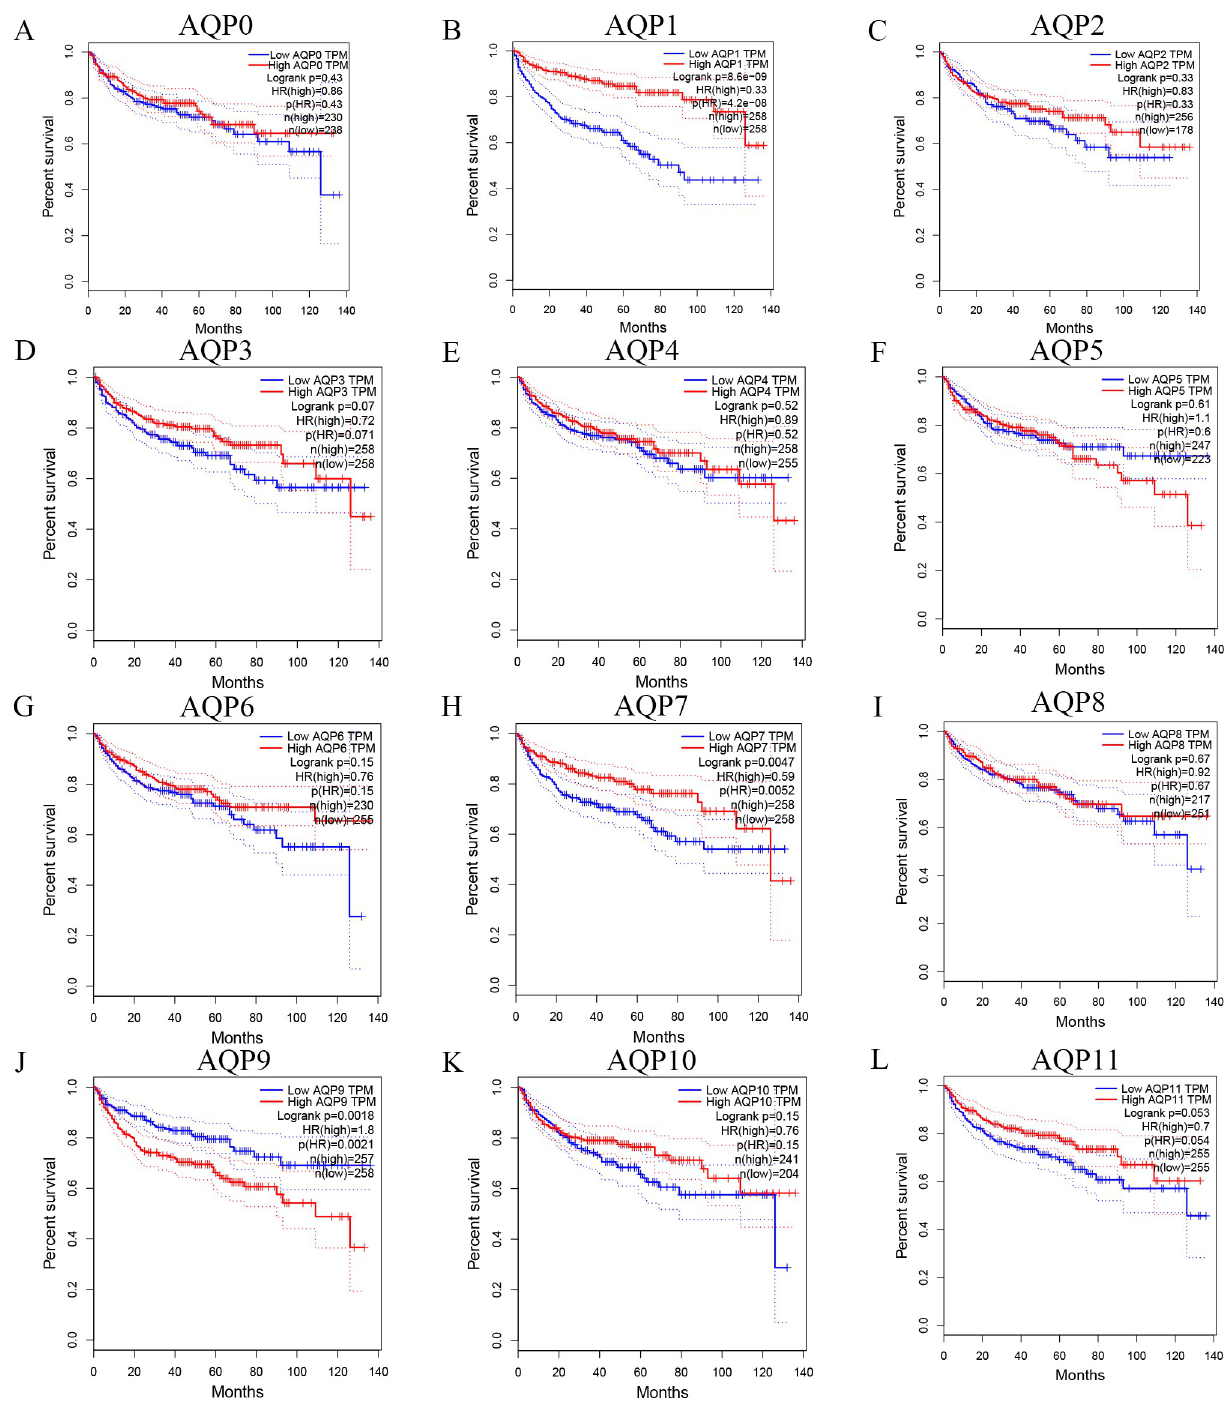
Fig 9. Prognostic significance of AQPs for the DFS of ccRCC patients (GEPIA). High expressions of AQP1/7 were associated with a better prognosis while high AQP9 expression was correlated with a poorer prognosis of the DFS in ccRCC patients.